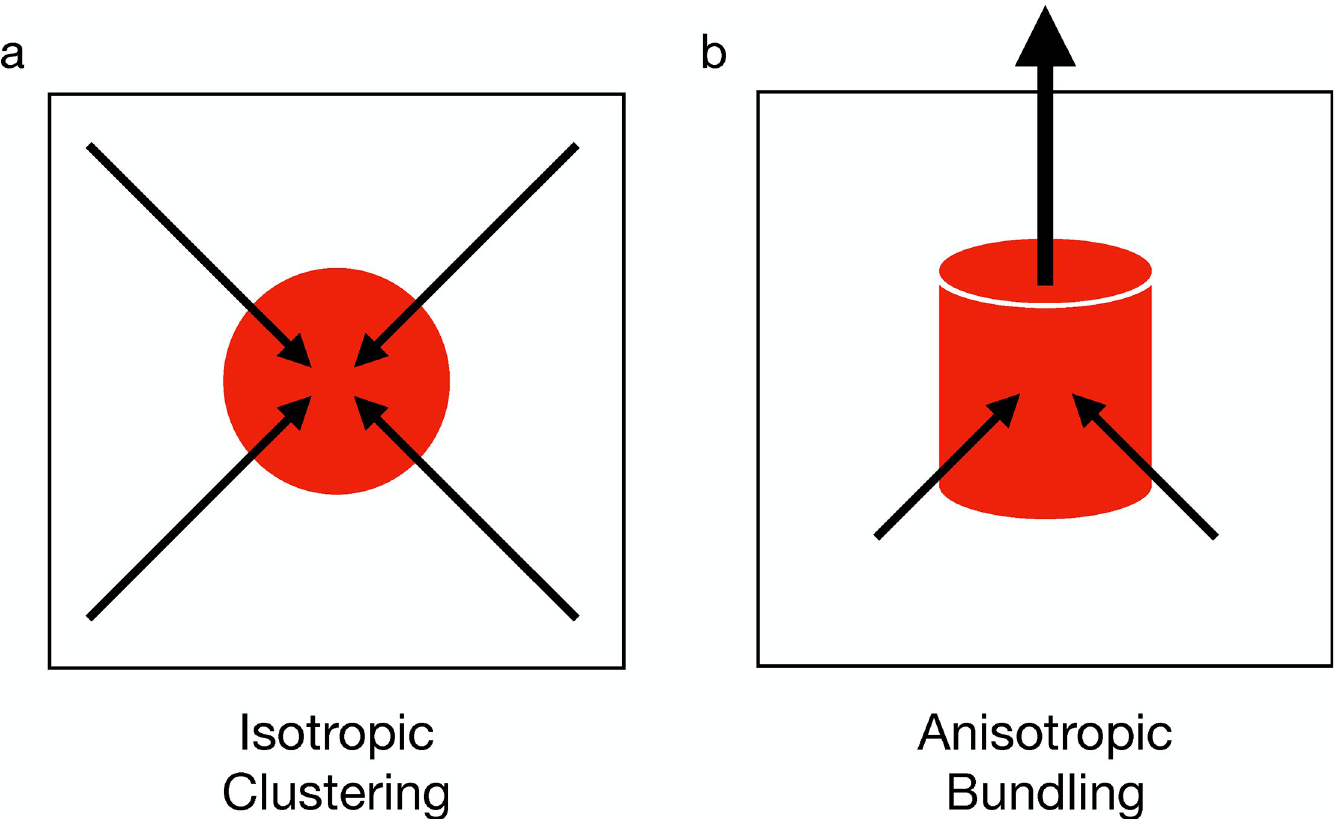
Fig 6. Motor-driven chemical evolution generates contractility that induces the geometric collapse of the actin network. In random networks without external forces, the geometric collapse would be isotropic, causing filaments to cluster into globular foci (a). However, the external tensile force induces filament directional alignment and favors anisotropic chemical evolution, resulting in filament bundling